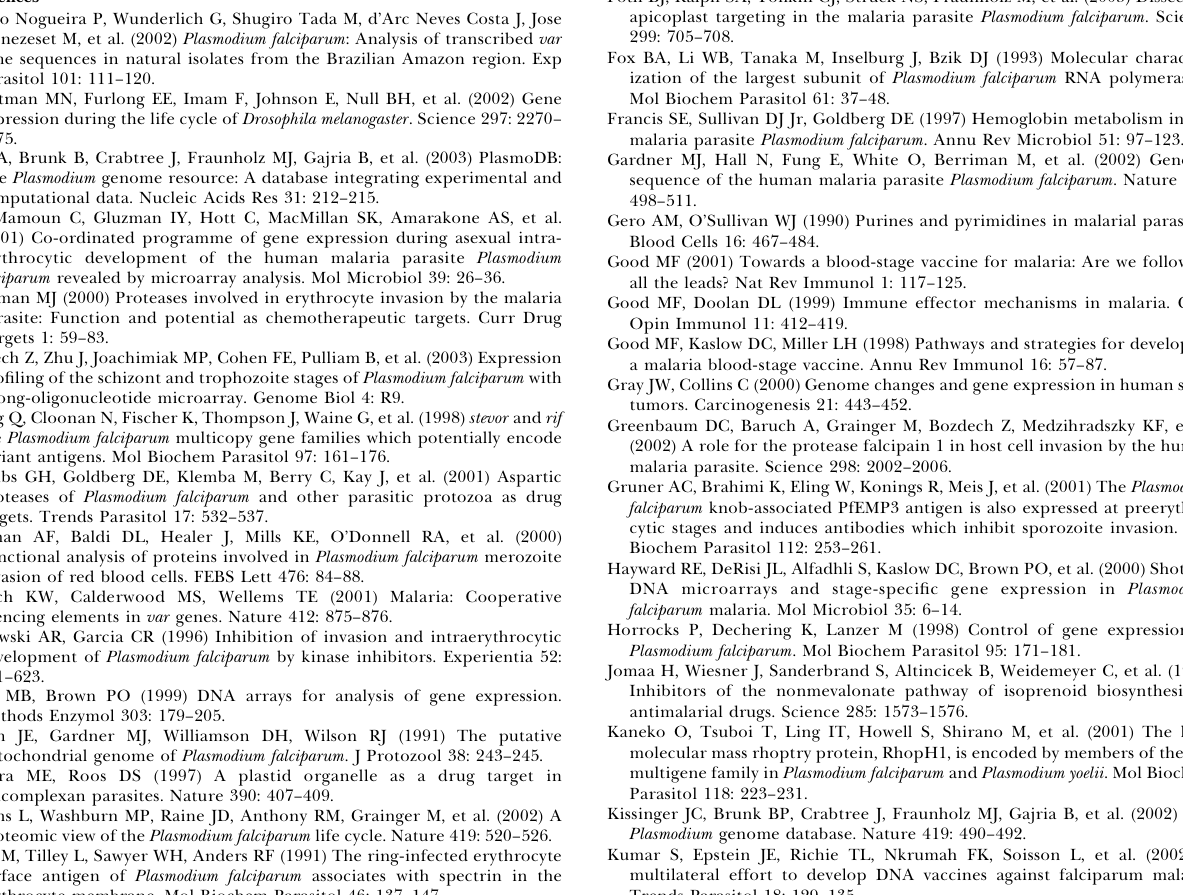
Table S6. Putative P. falciparum Proteases and Their Expression Data